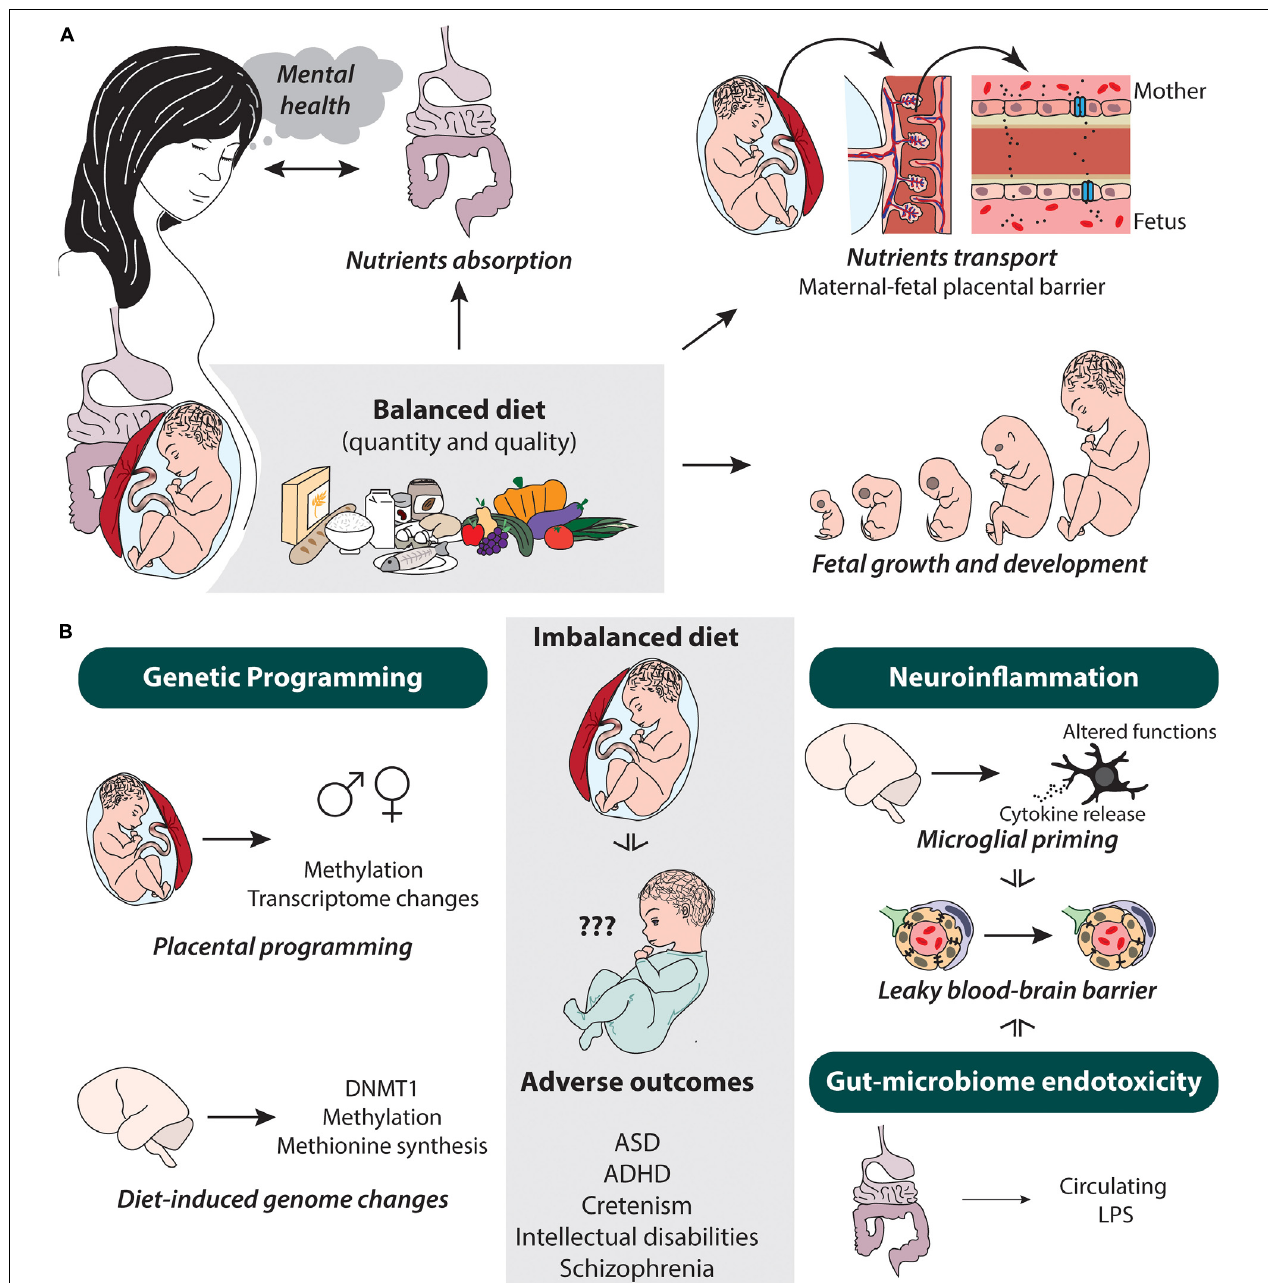
FIGURE 1 | Potential dietary-mediated factors altered by the pregnant mother’s diet and putative changes and mechanism occurring in the progeny. (A) Balanced diet influences on nutrient absorption and transport, as well as fetal growth and development in pregnant women. Their gut microbiome can also influence mental health state of the pregnant women. (B) In the offspring, diet can influence genetic programming (i.e., placental and genome-wide), neuroinflammation (i.e., microglia, cytokines, and blood–brain barrier leakiness), and gut microbiome endotoxicity, which in turn causes adverse neurodevelopmental outcomes such as ASD, ADHD, cretinism, intellectual disabilities, and